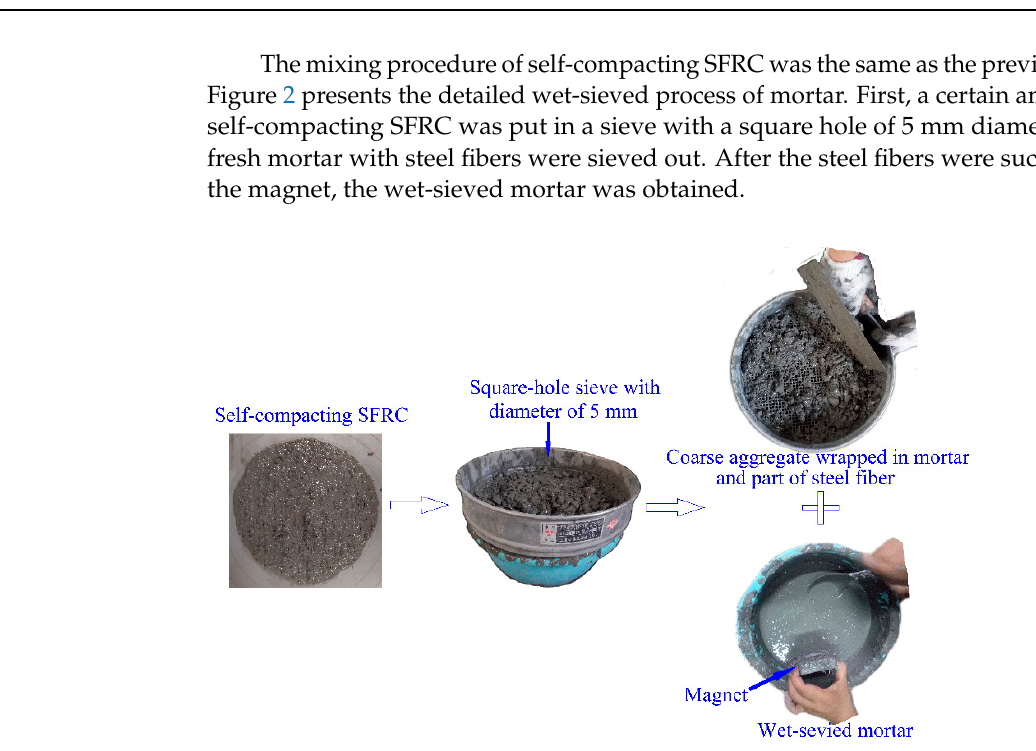
Figure 2. Detailed wet-sieved